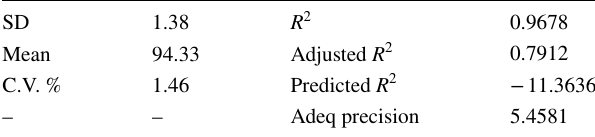
Table 7 Fit statistics of malachite green dye removal from